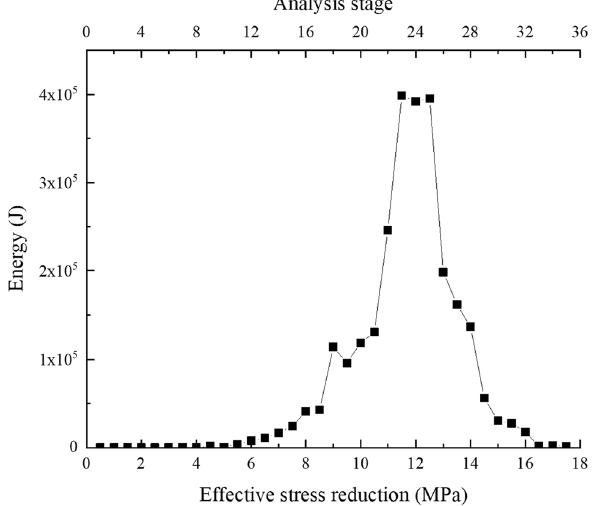
Fig. 12 Frequency distribution of moment magnitude at different analysis stages